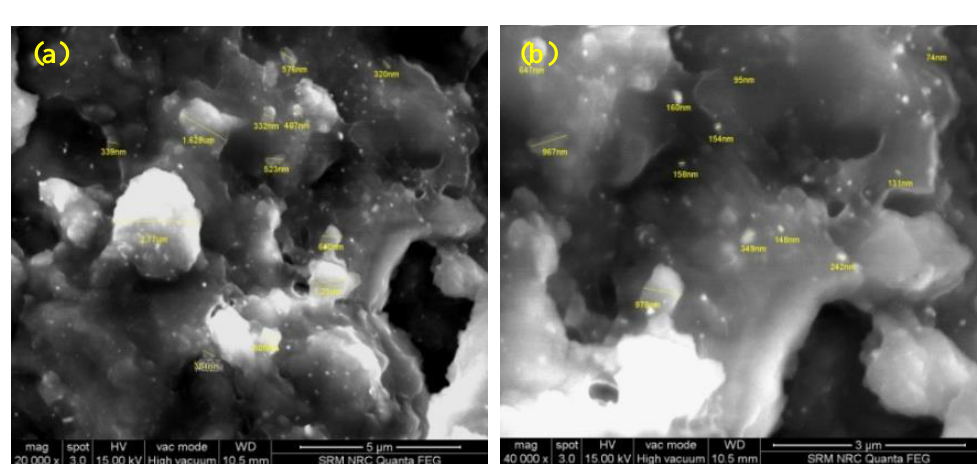
Figure 2. Particle size distribution PSA